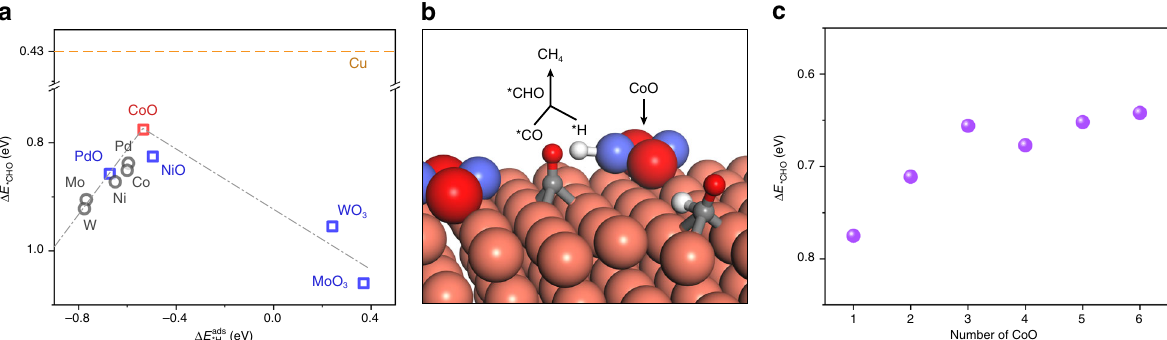
Fig. 1 Density functional theory calculations of carbon dioxide methanation. a Relationship between hydrogenation energy of *CO and surface *H binding energy for pure metal and metal oxide clusters on Cu surface. Red square for CoO, blue square for other oxides and grey circle for metals. The yellow dashed line is Cu baseline. b Schematic diagram of CO 2 to CH 4 on CoO cluster modi fi ed Cu surface. Tangerine for copper, violet for cobalt, red for oxygen, grey for carbon and white for hydrogen. c Hydrogenation energy of *CO for different sizes of CoO cluster. We introduced one cluster on the top of a 4-layer (5 × 2) Cu(111)